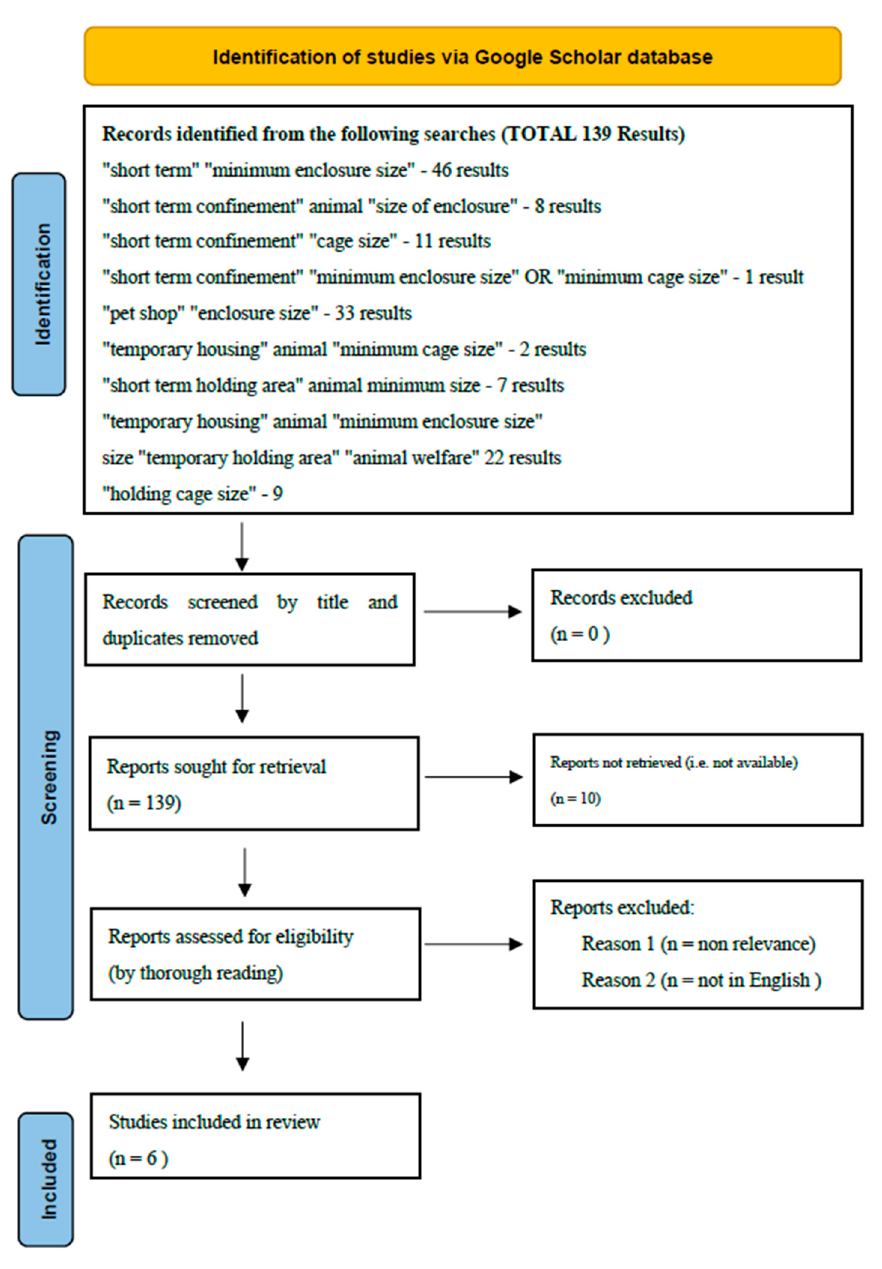
Figure 1. Search terms and strings for short-term, temporary, and transitional accommodation (each search was done separately, the results are combined, and the duplicates are removed). From: Page MJ, McKenzie JE, Bossuyt PM, Boutron I, Hoffmann TC, Mulrow CD, et al. The PRISMA 2020 state- ment: an updated guideline for reporting systematic reviews. BMJ 2021, 372, n71.